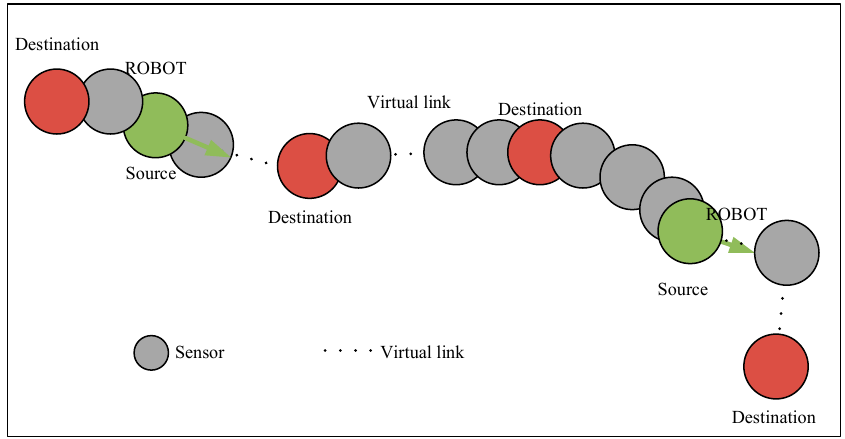
Figure 1. A typical dynamic barrier coverage problem.